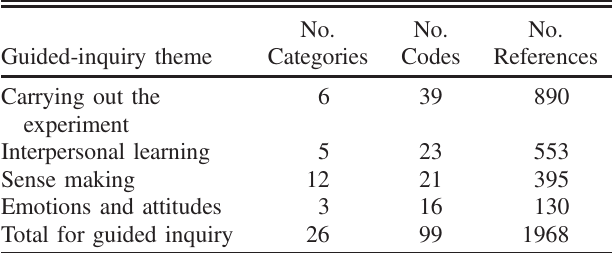
TABLE III. The number of categories, codes, and references in each of the themes in the guided-inquiry experiment. Note that there are 5 guided-inquiry data sets from the 5 groups of students who did the guided-inquiry experiment.